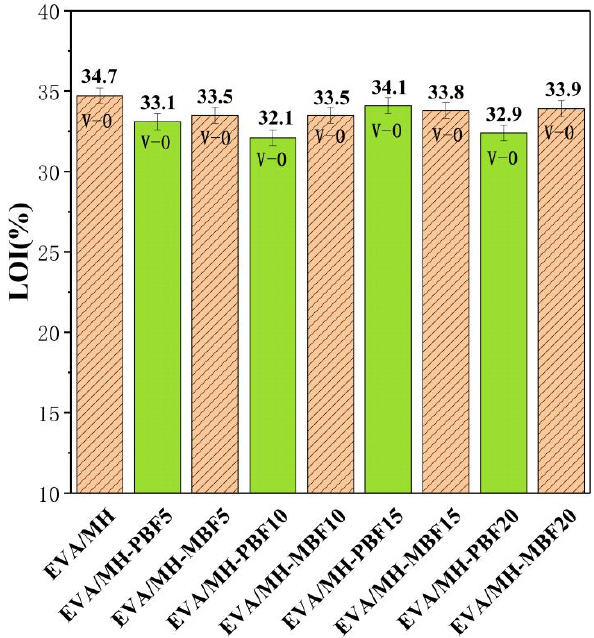
Figure 4. Limiting oxygen index (LOI) and UL-94 results for ethylene vinyl acetate / magnesium hydroxide-basalt fiber (EVA / MH-BF) composites.